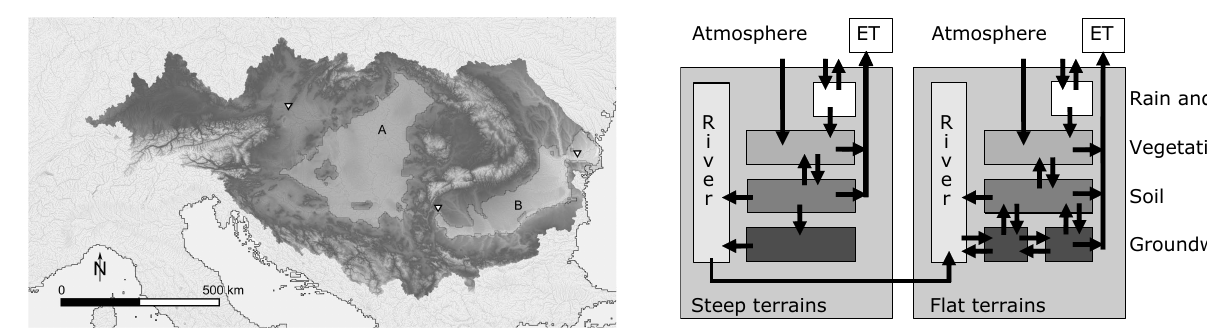
Fig. 1. Map of the Danube Basin. The regions labeled A and B are flat terrains where we modelled groundwater using MODFLOW. Region A is in the text referred to as the Pannonian Plain, region B the Wallachian Plain. The symbols 5 mark the river discharge measurement stations Bratislava, Iron Gate and Ceatal Izmail (from West to East).